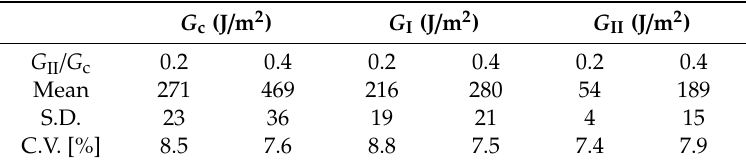
Table 2. MMB results, static loading.